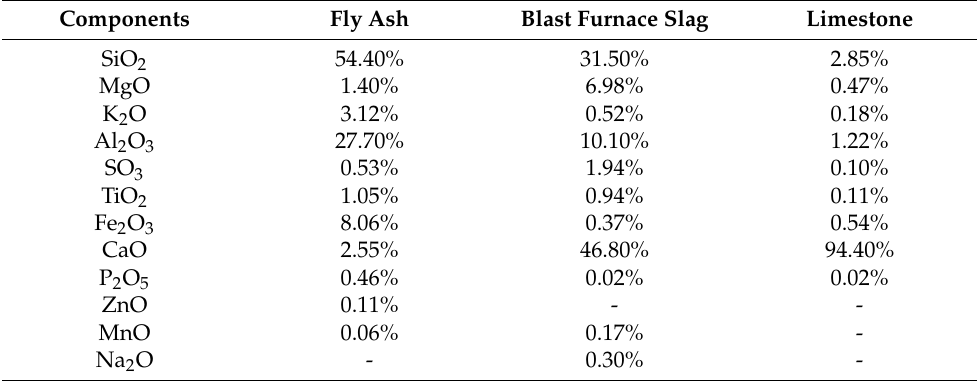
Table 2. Chemical composition of the additions used in this